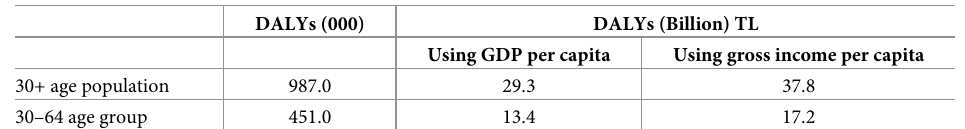
Table 7. Burden of DALYs in